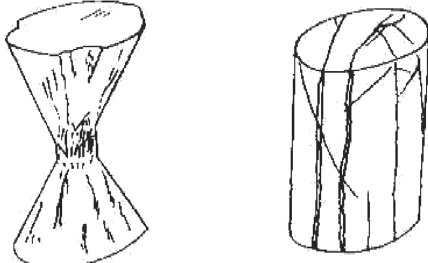
Figure 4: Two common failure modes of rock under uniaxial